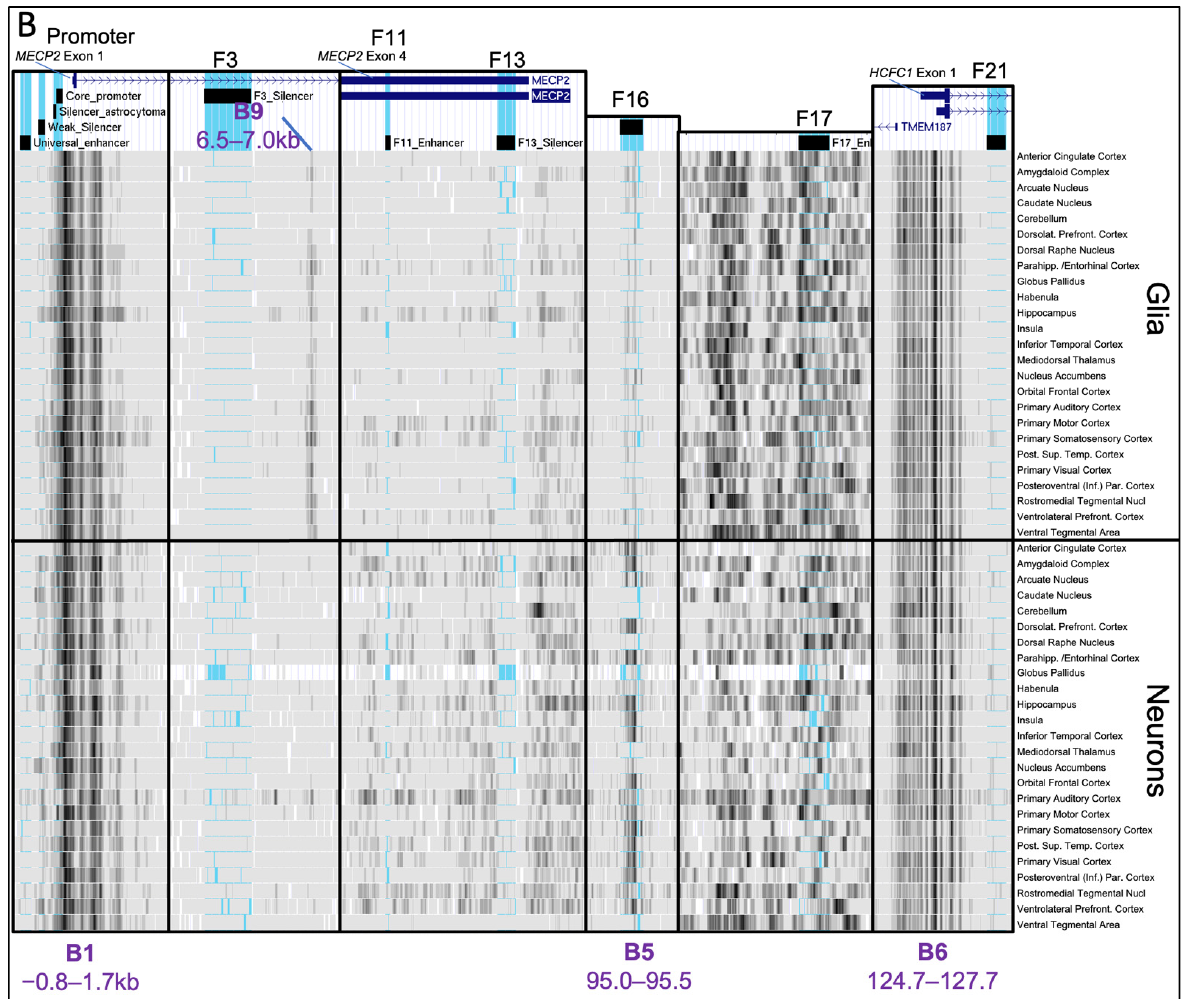
Figure 5. ATAC-seq of 25 brain regions: glia and neurons. ( A ) The chrX:153,947,013–154,101,440 genomic region of hg38 human genome assembly is displayed in UCSC genome viewing browser. Direction is 5 ′ –3 ′ (sense orientation relative to the MECP2 gene). Tracks displayed from top to bottom: ENCODE genes, mapping of previously identified [55] cis- REs (F3-F21) to genome, ATAC-seq data tracks. Cis -REs are highlighted in blue in UCSC. Scale on top represents distance equivalent to 50 kb. MECP2 exons are labeled on ENCODE Genes data track. Genomic segments with higher chromatin accessibility (darker regions) were labeled B1–B9. The distances are relative to the first nucleotide of MECP2 exon 1 (hg38 chrX:154,097,717). Labels are replaced for better readability. The labels define glial and neural cells from the 25-brain region analyzed Darker areas represent more mapping reads binding to that specific genomic region, hence higher chromatin accessibility. ( B ) Zoomed in portion of the genomes focused on the MECP2 promoter and cis -REs. Cis -REs are labeled inside and at the bottom of each box. The labels are the same as in panel ( A ). The ATAC-seq data tracks were uploaded from GSE211822.